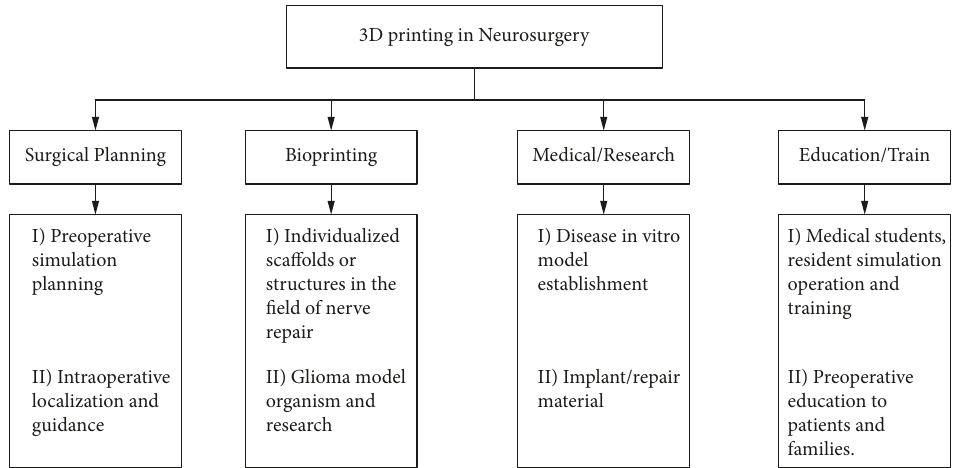
Figure 1: Flowchart of 3D printing applications in